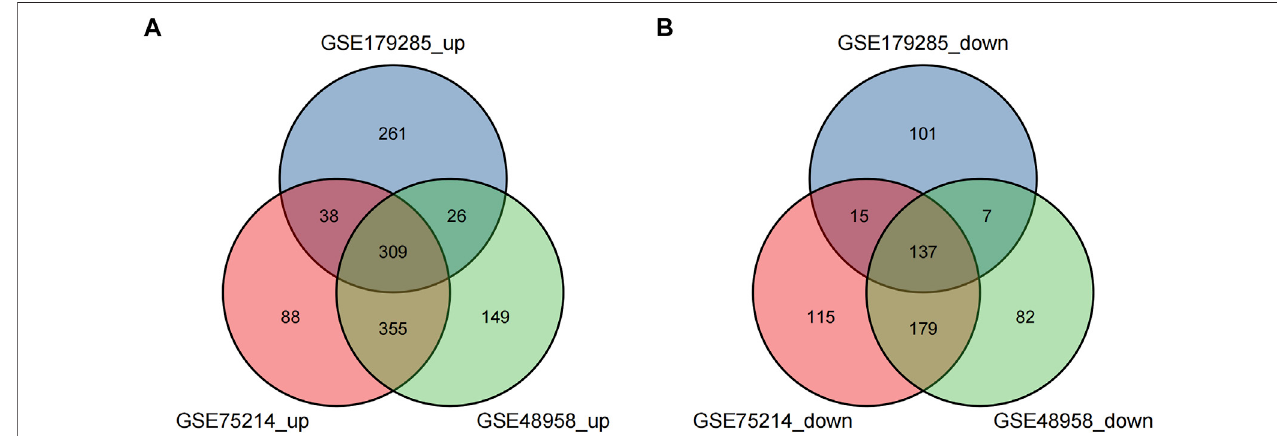
FIGURE 2 | Venn diagrams showing the differentially expressed genes (DEGs) that overlapped among the 3 datasets retrieved from Gene Expression Omnibus (GEO). (A,B) indicate the overlap of up-regulated and down-regulated genes in the GSE179285, GSE75214, and GSE48958 datasets, separately.